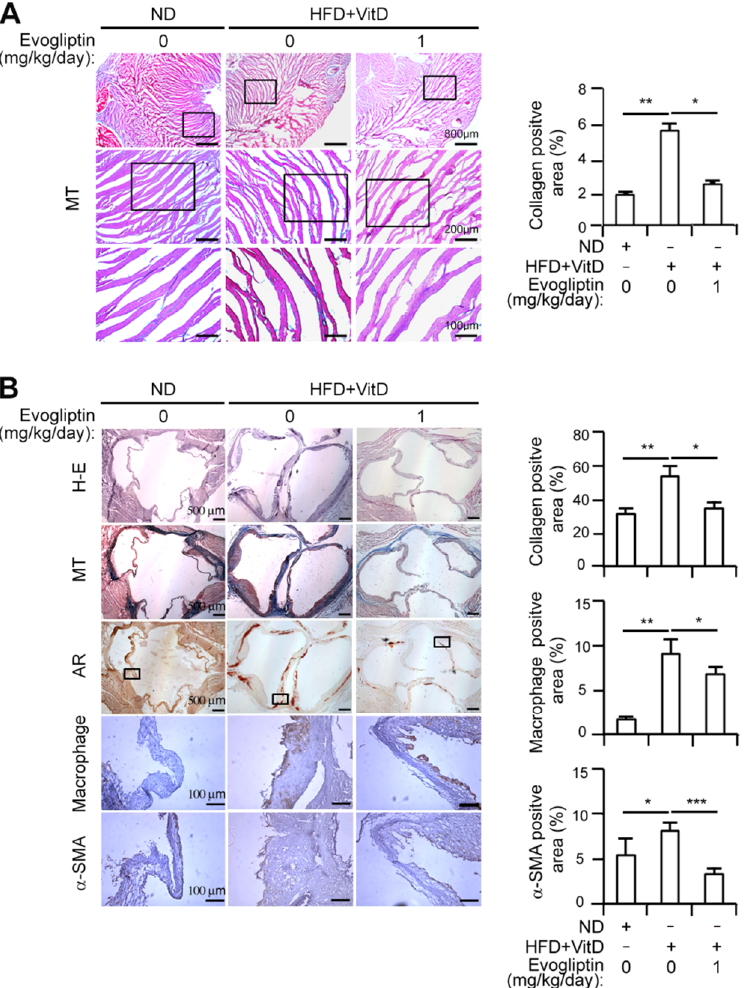
Figure 5. Effects of evogliptin on the aortic valve in a rabbit model with calcific aortic valve disease as determined by immunohistochemical staining. ( A ) Masson trichrome (MT) staining was performed to detect cellularity in the myocardium of a calcific aortic valve disease (CAVD) rabbit model showing extracellular matrix (ECM) accumulation (green–blue staining) (left). Quantitative analysis of the fibrotic area in the myocardium (right). ( B ) Representative photographs from light microscopy observations of the rabbit aortic valves with immunohistochemical staining for macrophage and α -SMA also shown (left). Hematoxylin and eosin (H–E), Masson trichrome (MT), and alizarin red (AR) staining were performed (left). Scale bar, 500 or 100 µ m. The areas positive for collagen, macrophages, and SMA were quantitated, respectively (right). * p < 0.05, ** p < 0.005, *** p < 0.0005 versus normal diet (ND) control. Data represent the mean ± SD. p values were obtained using nonparametric matched data analysis and a Wilcoxon’s signed rank